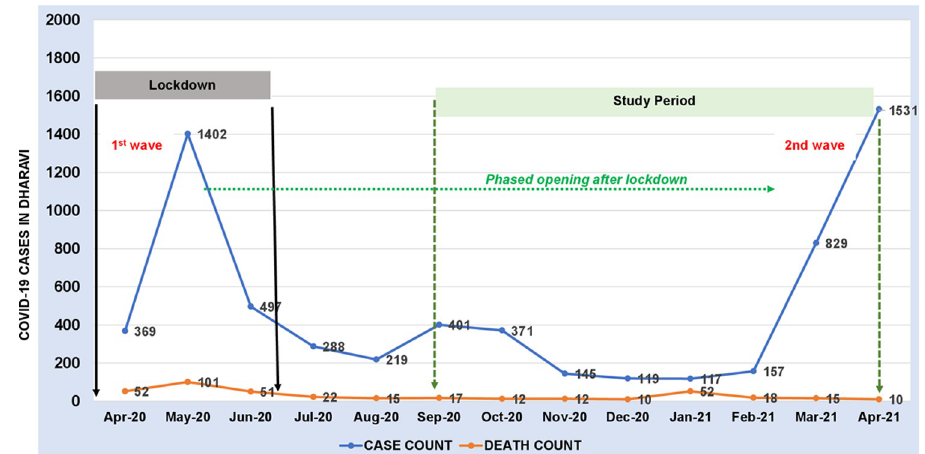
Fig 2. COVID-19 timeline in Dharavi and our study